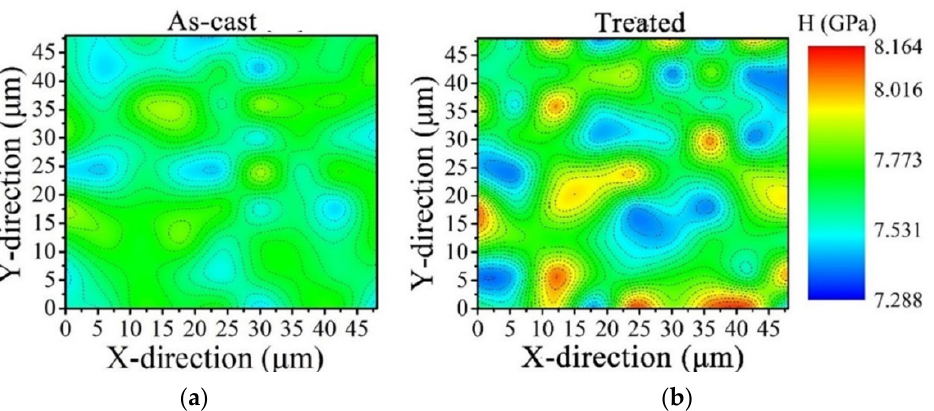
Figure 2. ( a , b ) are the distribution of the nano-indentation hardness of the as-cast [17] and treated sample, respectively.